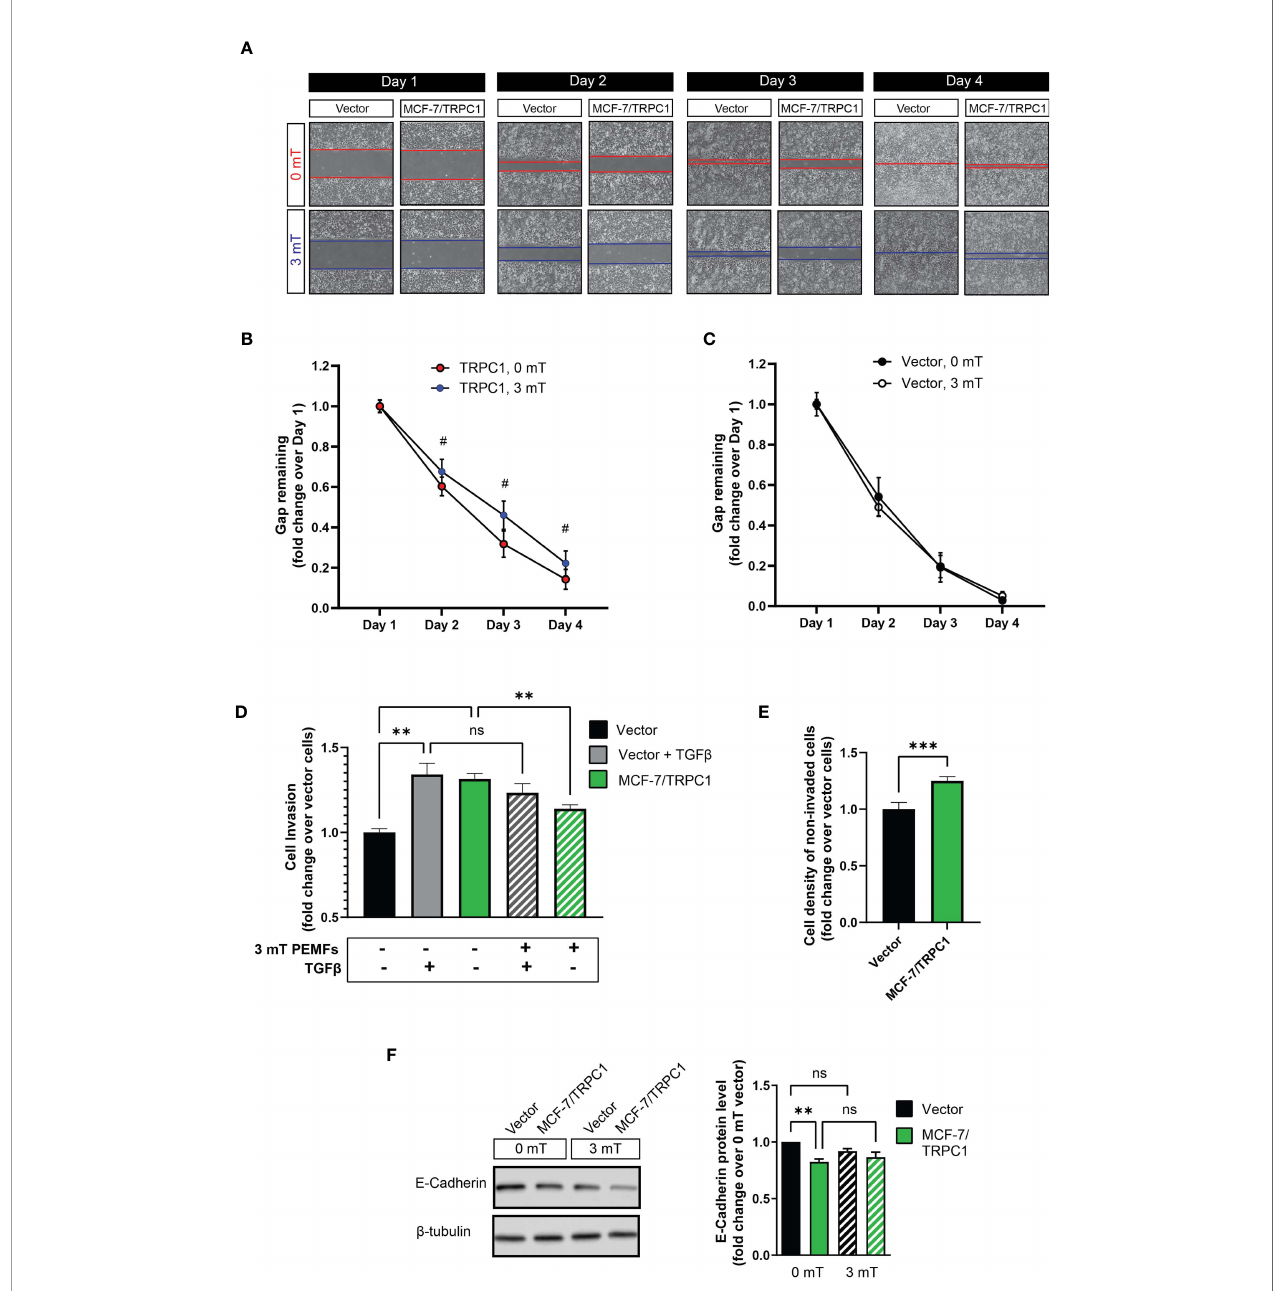
FIGURE 7 | PEMF exposure attenuates migration and invasion of MCF-7/TRPC1 cells. (A) Photographic comparison of the migration of vector-transfected and MCF-7/TRPC1 cells exposed to 0 or 3 mT PEMFs. Cells were plated at a density of 30,000 per well and allowed to settle for 24 h before the removal of the insert. Cells were exposed to PEMFs for 1 h on the second, third and fourth days. Time course of gap closure for (B) MCF-7/TRPC1 (0 and 3 mT) and (C) vector (0 and 3 mT) cells normalized to day 1. (D) Quanti fi cation of stained (invading) cells expressed as fold change relative to vector cells. The stained cells correspond to those that successfully invaded the basal membrane and are present on the lower side of the membrane after 48 h. Untreated vector cells served as a reference of basal cell invasion (black). Gray bars represent vector cells that had been treated with TGF b during seeding to promote invasion in combination with (hatched) and without (solid) 3 mT PEMF exposure at seeding and 24 h later. (E) Cell density on the upper side of the insert after 48 h post-seeding. The cells were stained and lysed using the same schedule as for the invasion assay. (F) Western analysis of E-cadherin protein expression in vector and MCF-7/TRPC1 cells with and without PEMF exposure for 3 consecutive days. E-cadherin protein levels shown as fold change relative to that of 0 mT of vector cells. All results were from 3 to 5 independent experiments with ** p < 0.01, *** p < 0.001 and # p < 0.0001. The error bars are expressed as the standard error of the mean. “ ns ” indicates nonsigni fi cant